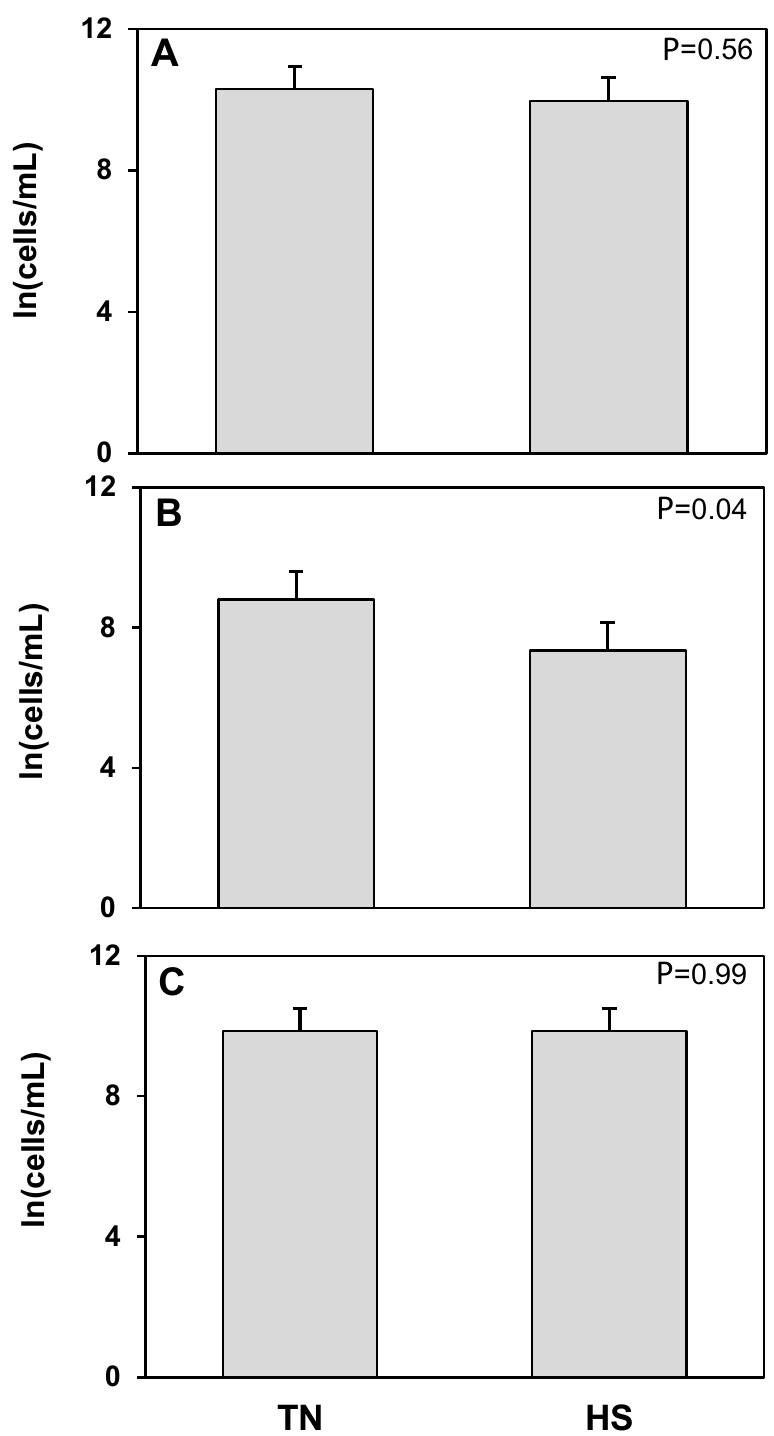
Figure 4. Heat stress (HS) impacts on granulocyte (Granulocyte + CD45 + ) cell concentration in milk compared to thermoneutral (TN) conditions. ( A ) Total cells, ( B ) live cells (propidium iodide negative; PI − ), and ( C ) dead cells (propidium iodide positive; PI + ). Cell population data were natural log transformed for statistical analysis. Values presented are least square means of natural log transformed data with error bars presenting the SEM (n = 10).